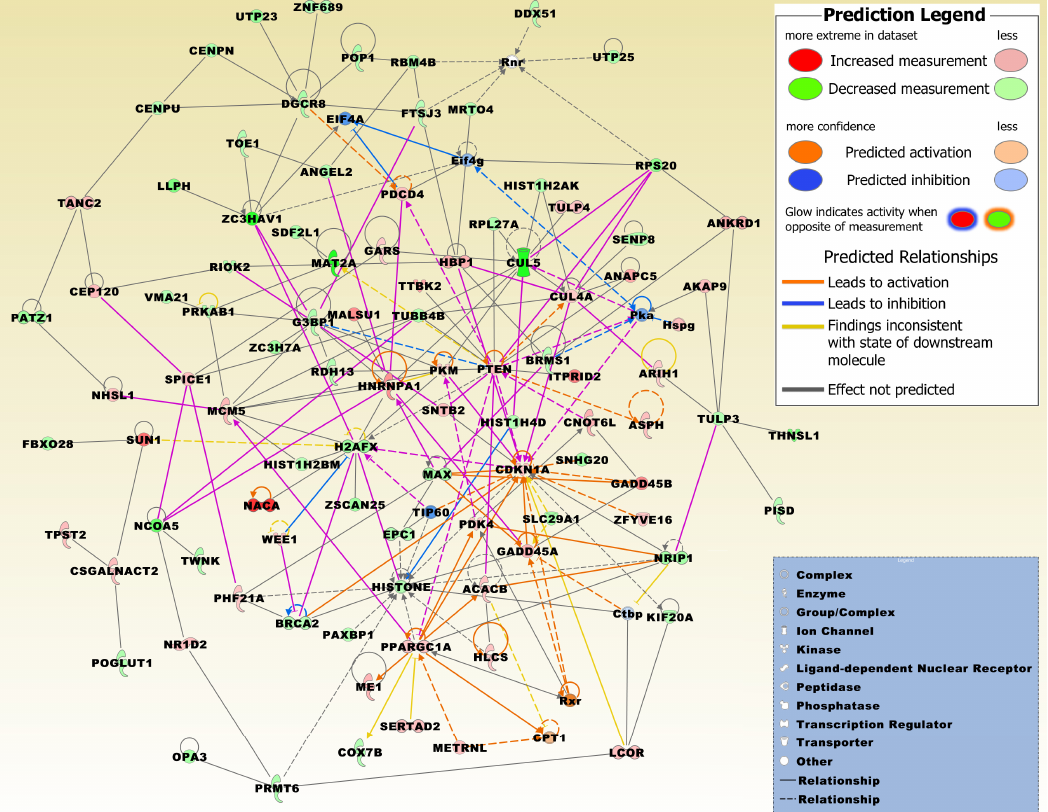
Figure 2. The merged network is based on the top three networks that were most significantly related to the microarray expression profiles of the 830 DEG set, which were either significantly up- or down-regulated in at least two di ff erent conditions. Network molecules are related to carbohydrate and lipid metabolism, small molecule biochemistry, cancer, cell cycle, cellular assembly and organization, DNA replication, recombination and repair, and molecular transport (Table 2). Upregulated